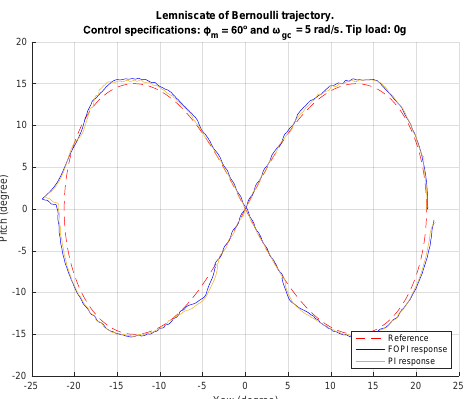
Figure 13. PI and FOPI system response to a lemniscate of Bernoulli input reference. Control specifications: φ m = 60 ◦ and ω gc = 5 rad/s. Tip load: 0 g.